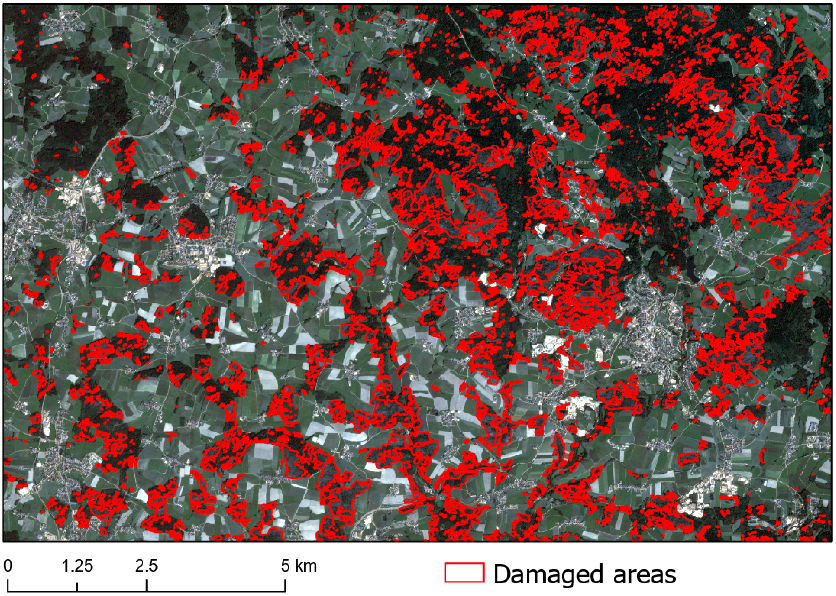
Figure 1. Full extent of the study area with aerial images and respective labels for damaged areas overlain as red polygons. Due to confidentiality agreements, we are not able to add location detail.